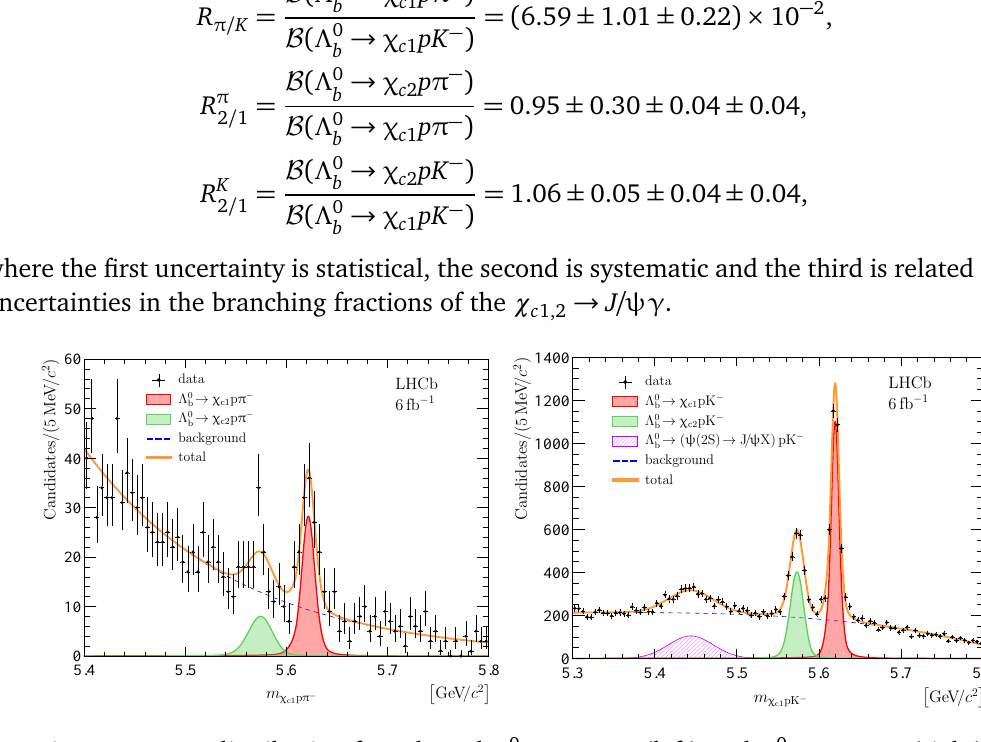
Figure 4: Mass distribution for selected Λ 0